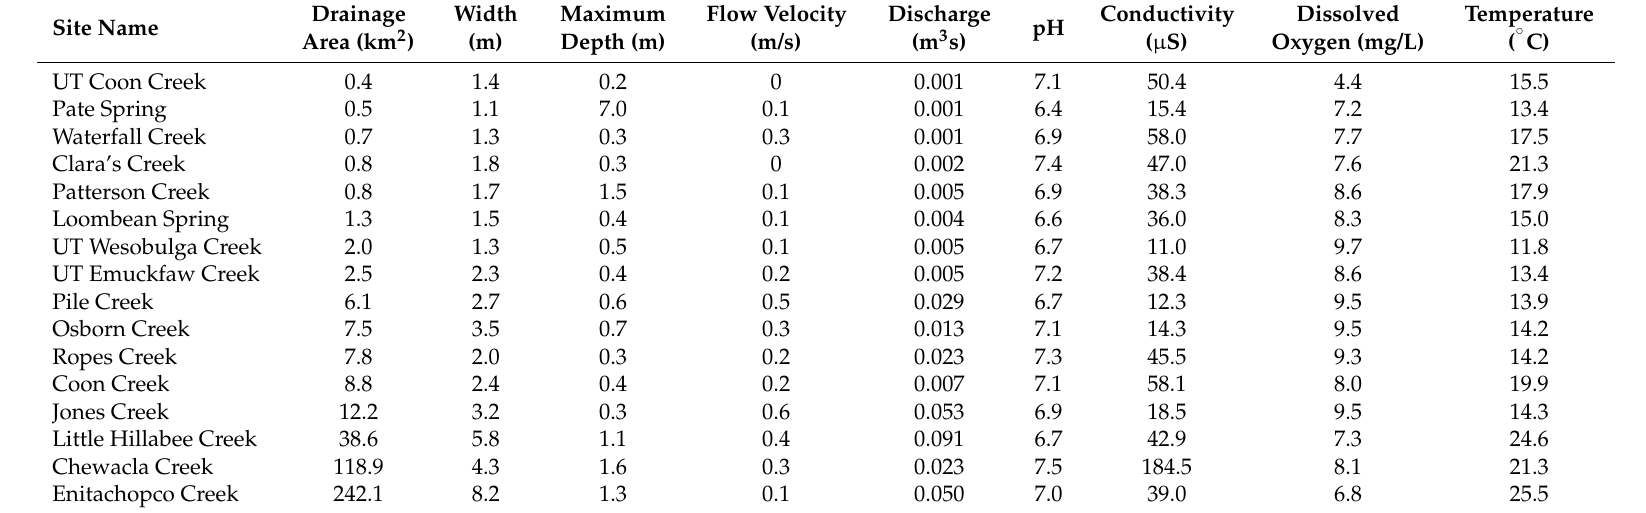
Table 4. Streams sampled for biotic assemblages and associated mean physicochemical conditions at time of